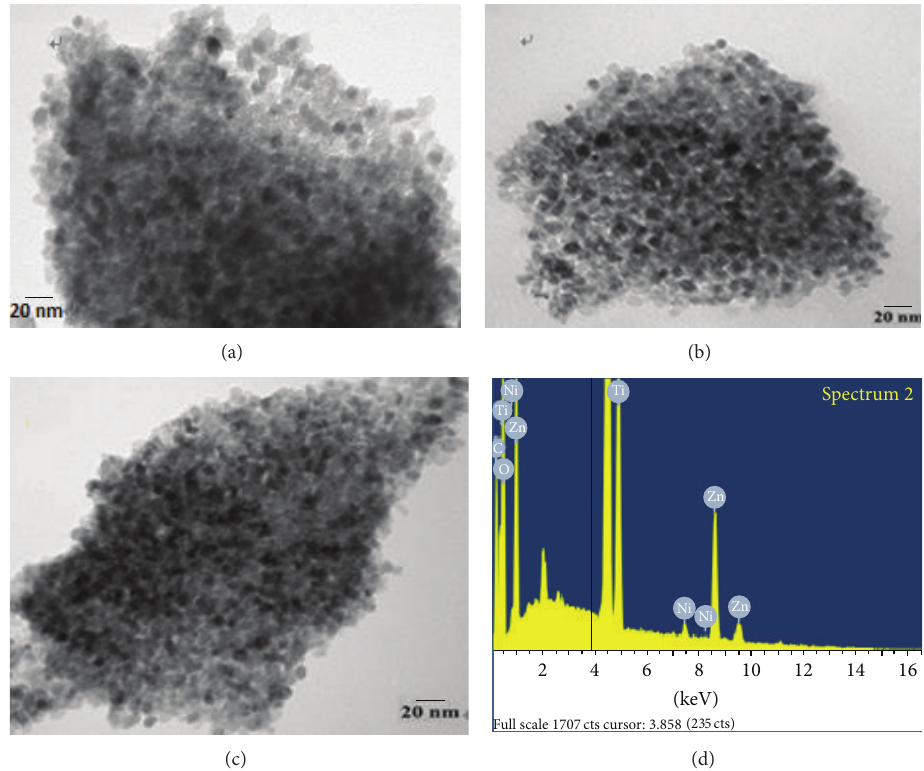
Figure 3: TEM micrograph of (a) TiO 2 , (b) ZnO-TiO 2 , and (c) Ni doped ZnO-TiO 2 and (d) EDX spectra obtained from Ni doped ZnO-TiO 2